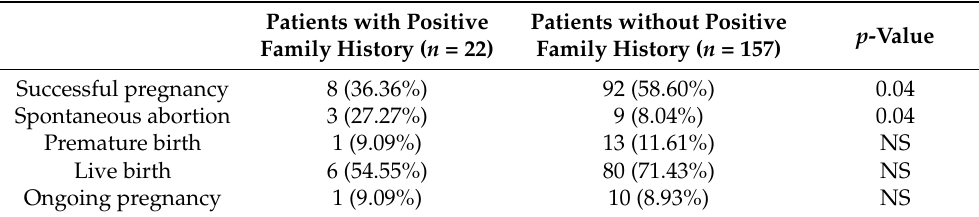
Table 7. Comparison of naturally conceived pregnancy outcomes between recurrent endometriosis patients with and without family